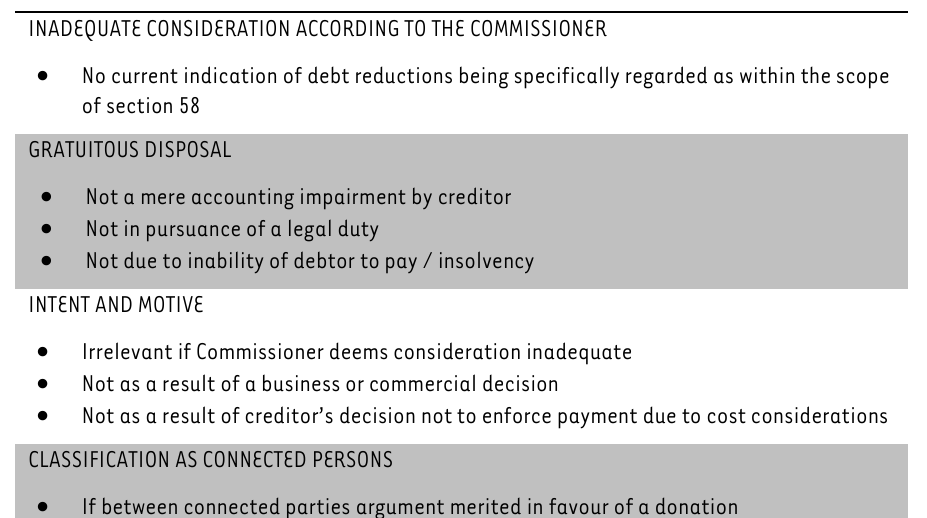
TABLE 1: Indicative factors in classification as a